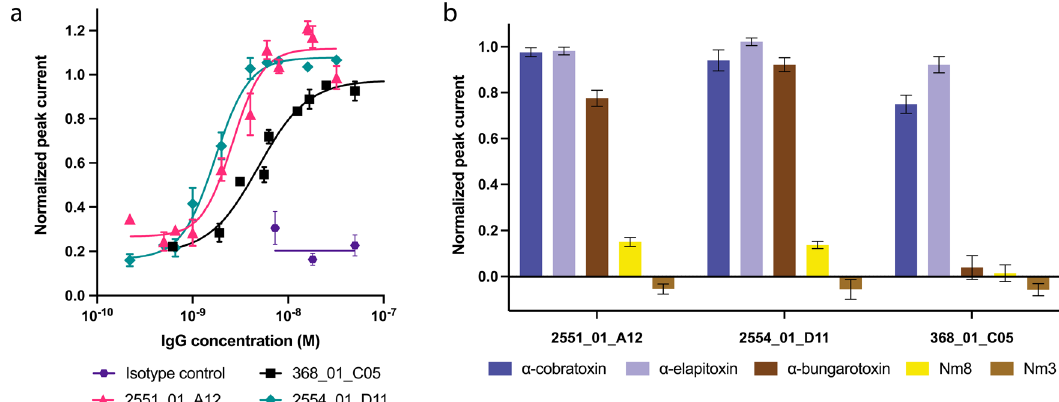
Fig. 4 | Electrophysiological determination of the in vitro cross-neutralizing potentialof2551_01_A12,2554_01_D11,and368_01_C05. Automatedpatch-clamp experiments were performed to determine the ability of the antibodies to prevent the current-inhibiting effect that α -neurotoxins exert on the nAChR. a Concentration-response curves illustrating how increasing concentrations of the three antibodies prevent nAChR blocking by α -cobratoxin (SD shown, each data- point based on at least n =4 independent experiments, one experiment equals 10 cells). b Single concentration plot outlining the cross-neutralizing potential of the